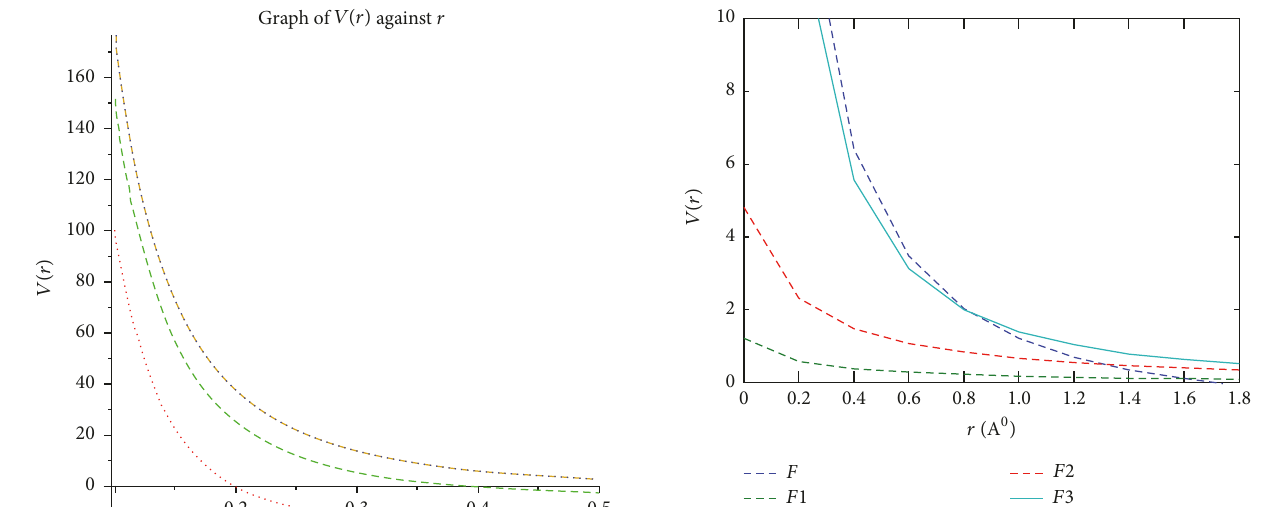
Figure 2: The graph of the HYIQP as compared to that of individual potentials. 𝐹 = HYIQP potential, 𝐹 1 = Hulthen potential, 𝐹 2 = Yukawa potential, and 𝐹 3 = inversely quadratic potential.